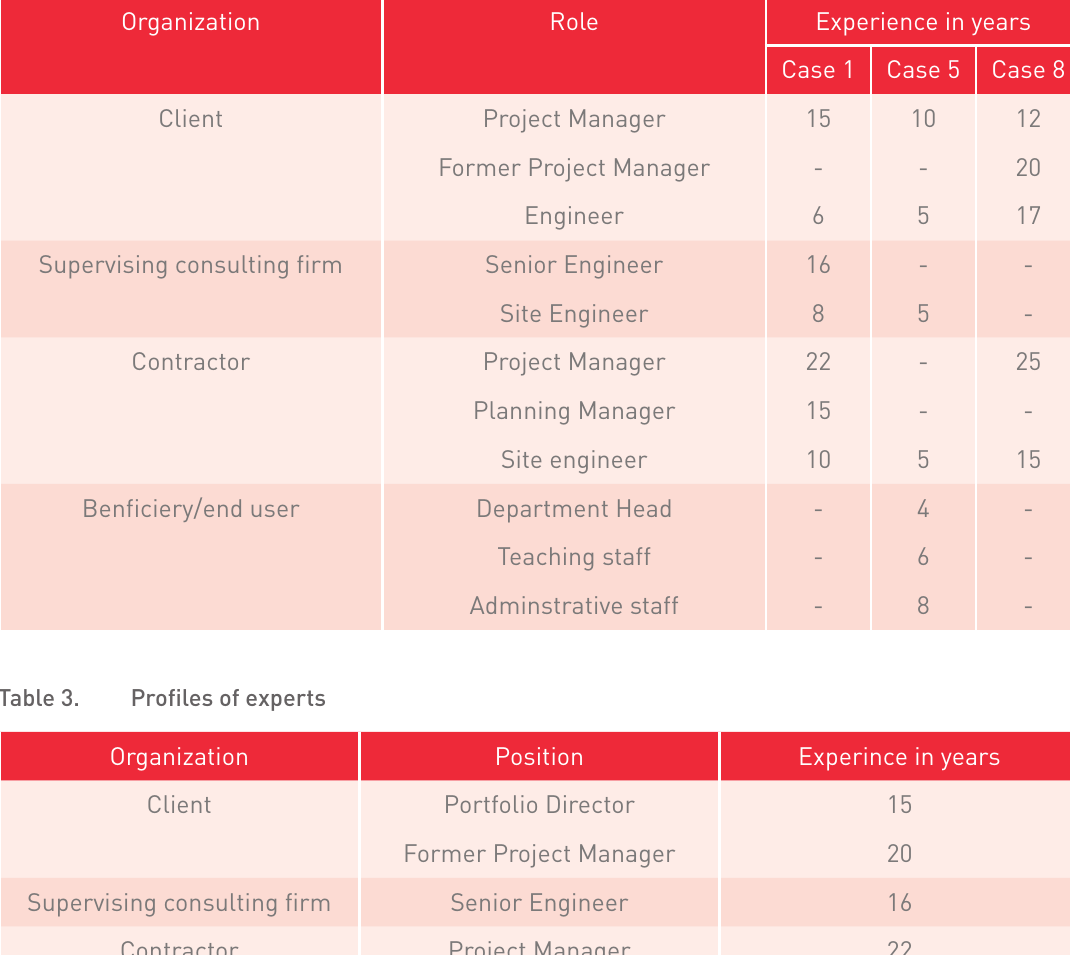
Profiles of participants in focus-group discussions